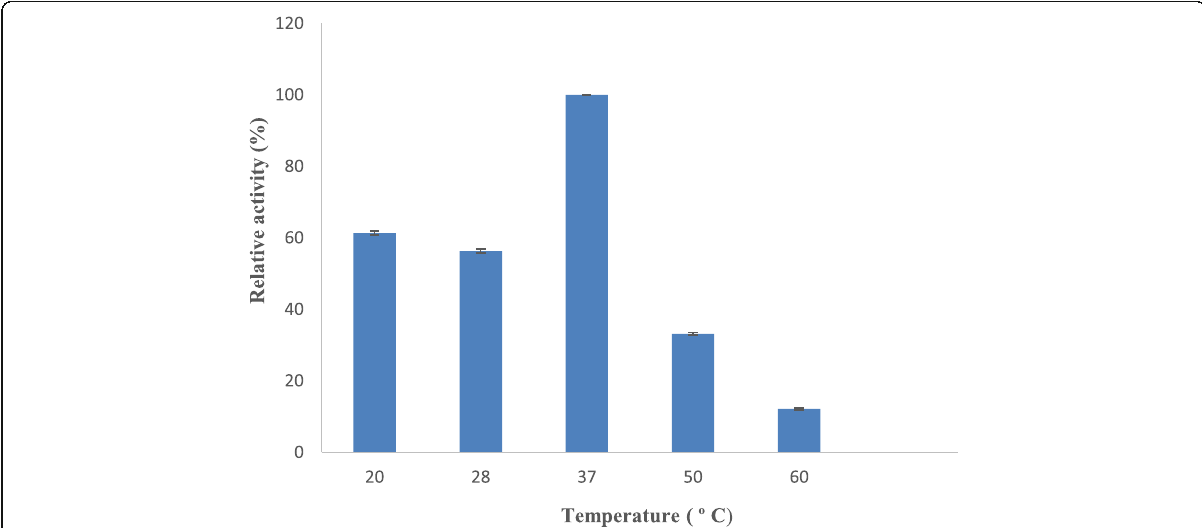
Fig. 5 Effect of temperature on serratiopeptidase activity. The enzyme activity was measured at different temperatures (20 °C, 28 °C, 37 °C, 50 °C, and 60 °C) using a standard assay method. Each value represents the mean ± SD for three